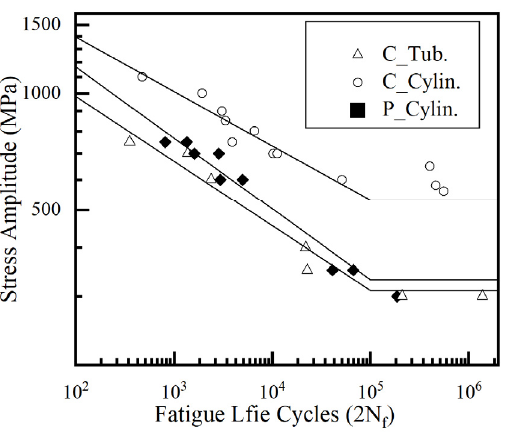
Figure 6. Reversals to failure of pseudo-carburized specimens and carburized specimens.